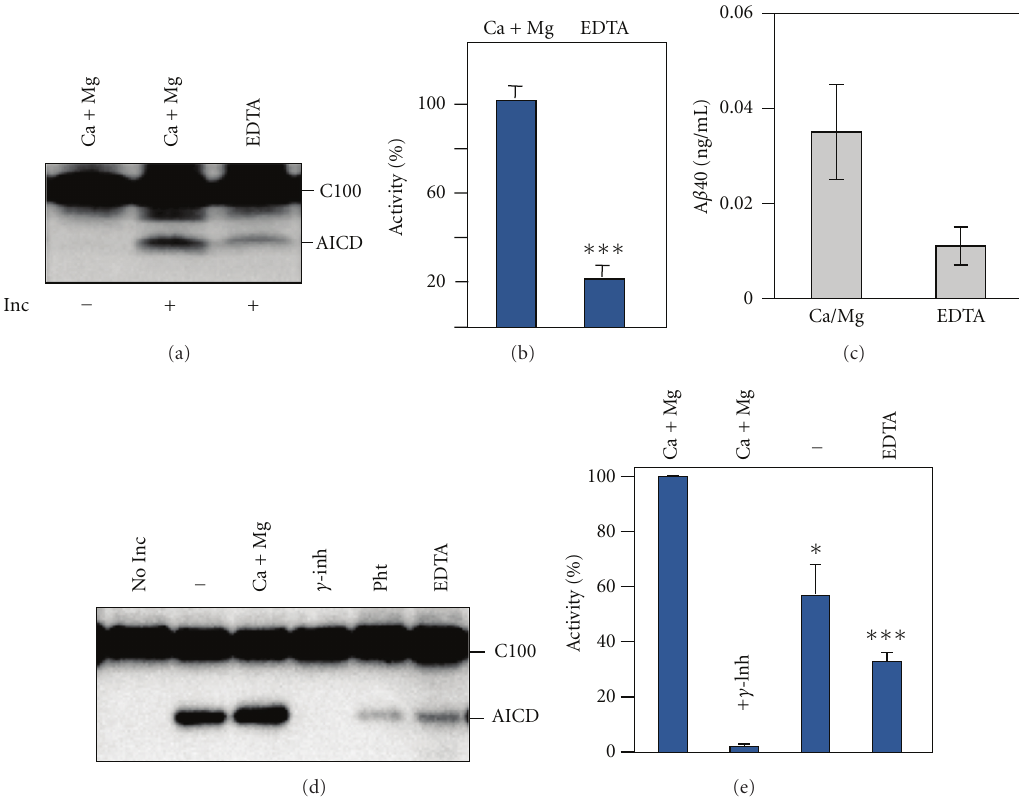
Figure 3: E ff ect of EDTA and phenanthroline on γ -secretase activity. (a) Guinea pig γ -secretase activity was assayed on C100-3XFLAG in alternate bu ff er conditions (2mM EDTA or 3 mM CaCl 2 and 3mM MgCl 2 ). (b) Quantitative analysis of five separate experiments shows AICD production in the presence of EDTA was 28% of that produced in the presence of CaCl 2 , and MgCl 2 . (c) Quantitative analysis of A β 40 by sandwich DELFIA shows that A β production in the presence of EDTA is lower than in the presence of CaCl 2 , and MgCl 2 . (d) γ -Secretase activity extracted from SH-SY5Y membranes was assayed in bu ff er conditions as indicated. Phenanthroline (Pht) concentration was 5mM. L-685,458 was 0.5 μ M. (e) Quantitative analysis of three blots corresponding to assays carried out as in (d) The error bars represent